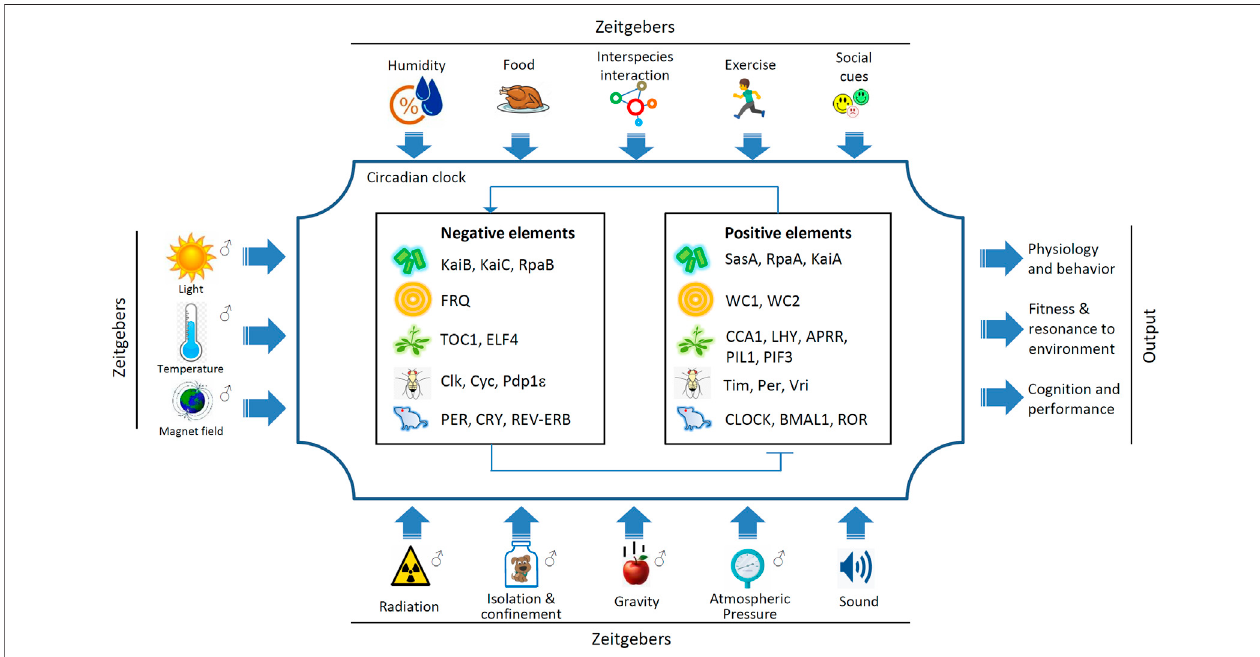
FIGURE1 | Themolecularcontrolofcircadianclock systems. The negativeand positive elements of circadian clockfactors in representative models are depicted, and bacteria ( S. elongatus ), fungi ( N. crassa ), plants ( A. thaliana ), insects ( D. melanogaster ), and mammals ( Mus musculus ) are depicted (Bell-Pedersen et al., 2005; Doherty and Kay, 2010; Zhang et al., 2011). Environmental cues that dramatically differ from those on Earth are presented. Note that in this fi gure, cognition refers to animals only and performance refers to humans only. Isolation and con fi nement apply to animals and